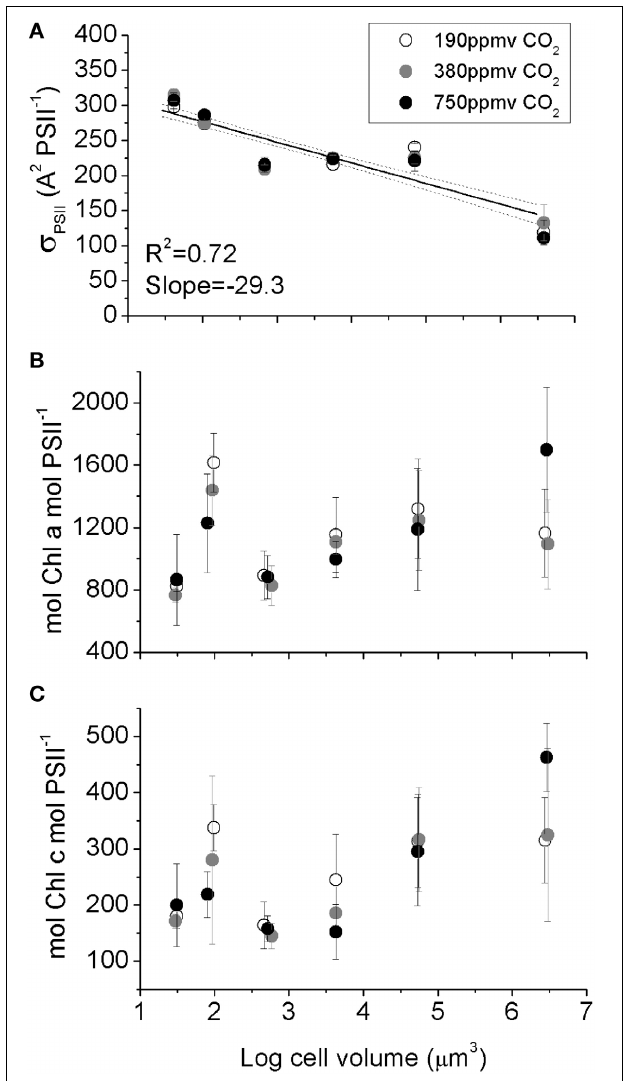
FIGURE 4 | (A) Effective blue light absorbance cross section for Photosystem II, (B) Chl a PSII − 1 , (C) Chl c PSII − 1 plotted vs. log 10 cell volume. The significant decrease in σ PSII with increasing cell size (A) reflects optical packaging effects because Chl per PSII (B,C) does not decline with cell size. Solid line indicates pooled linear regression for samples from the three p CO 2 levels. Dotted lines indicate the 95% confidence band on the regression. Cultures were grown under p CO 2 190ppmv (open symbols); 380ppmv (shaded symbols) or 750ppmv (black symbols). n = 3–6.